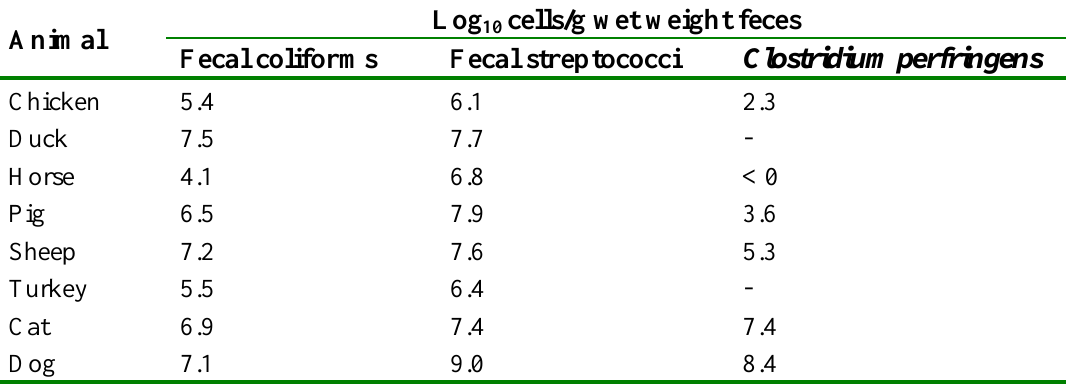
Table 7. Bacteria in the feces of farm and domestic warm-blooded animals a